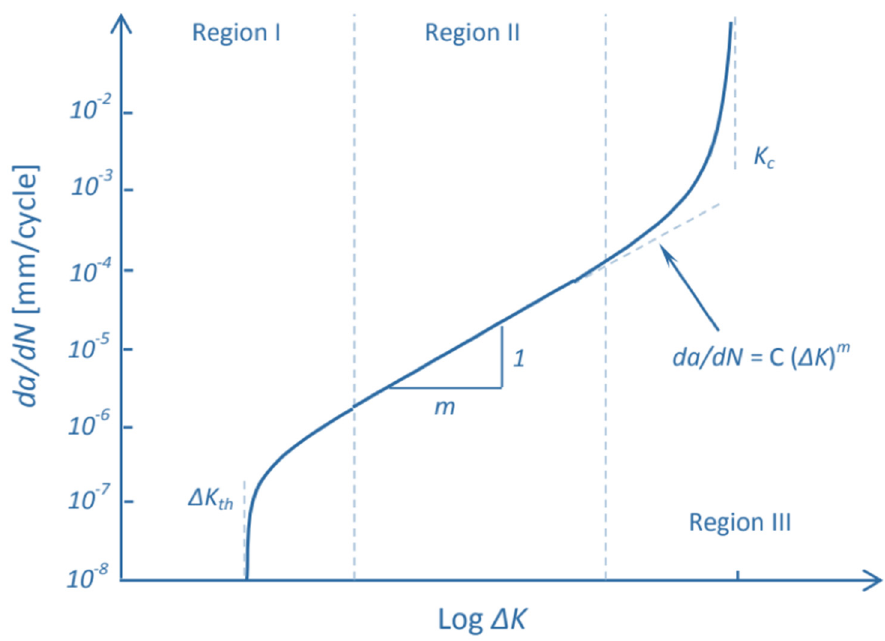
Figure 6. Fatigue crack propagation regimes.